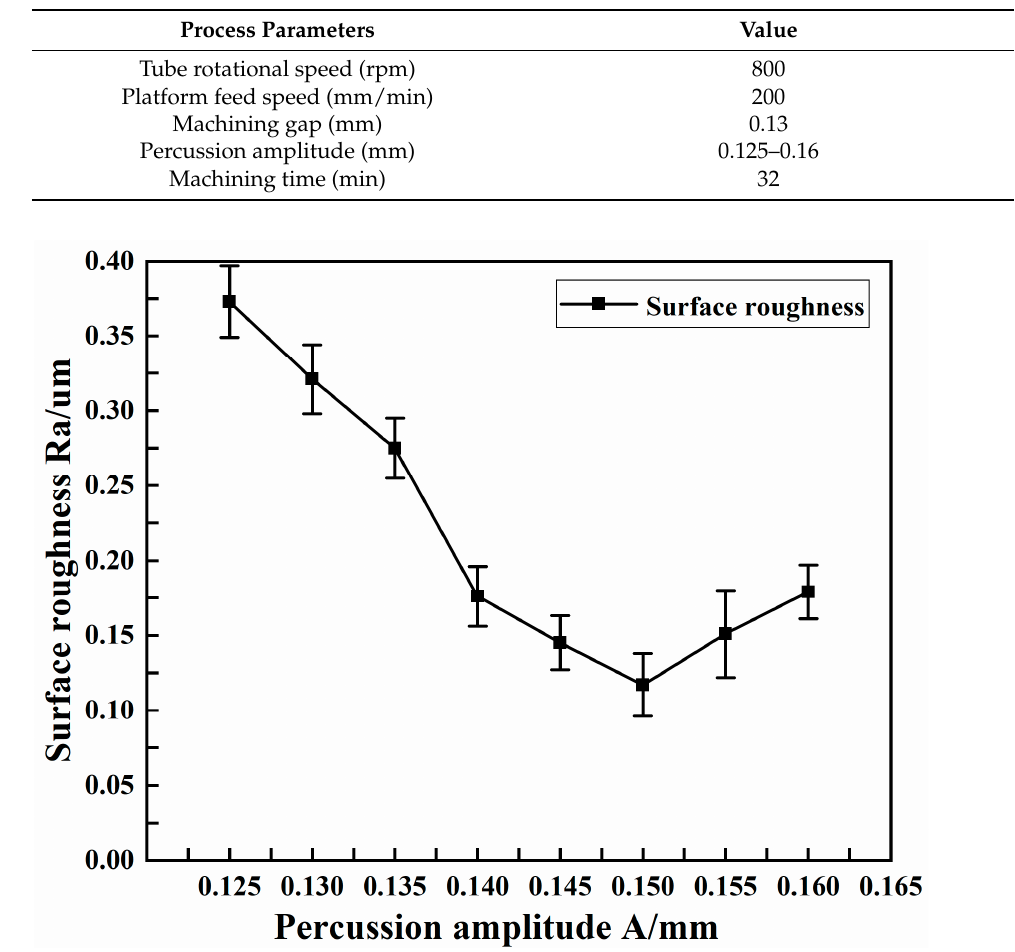
Figure 11. Effect of percussion amplitude on surface roughness.